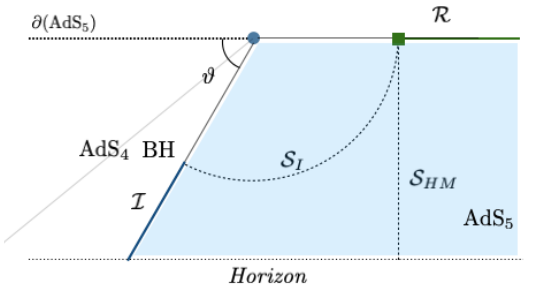
Figure 1 . Karch-Randall setup: funnel configuration with AdS 4 black hole on the EOW brane within the AdS 5 , bent at an angle with respect to the conformal boundary of the bulk. The blue segment on the brane is the Island, on the boundary of which is anchored the island surface, ending on the endpoint of the radiation region, denoted by the green segment, on the conformal boundary. The dashed line segments correspond to the two kinds of RT